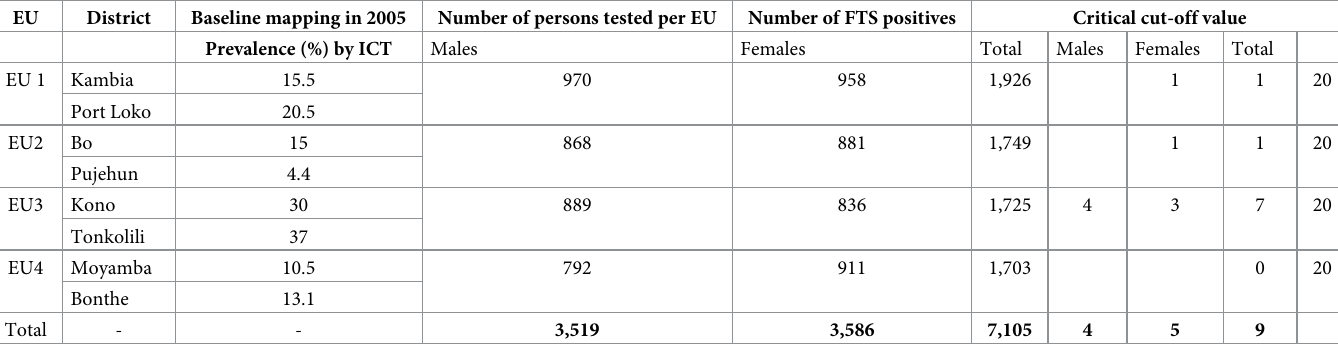
Table 1. Results of transmission assessment surveys (TAS) in eight districts in four EUs in Sierra Leone in 2017. EU District Baseline mapping in